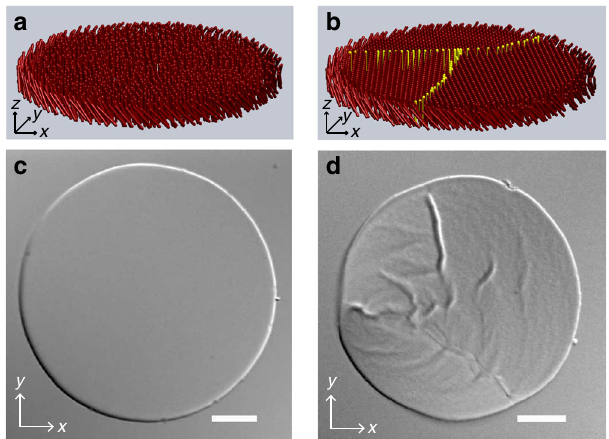
Fig. 1 Fluid and crystalline phases of colloidal membranes. a Schematic of a fl uid colloidal membrane. b Schematic of a polycrystalline colloidal membrane assembled with more than one nucleation center. Yellow rods highlight the domain walls. c Differential interference contrast (DIC) image of a fl uid colloidal membrane at 20 mg ml − 1 PEG concentration. Scale bar, 10 μ m. d DIC image of solid colloidal membrane at 24 mg ml − 1 PEG concentration. Scale bar, 10 μ